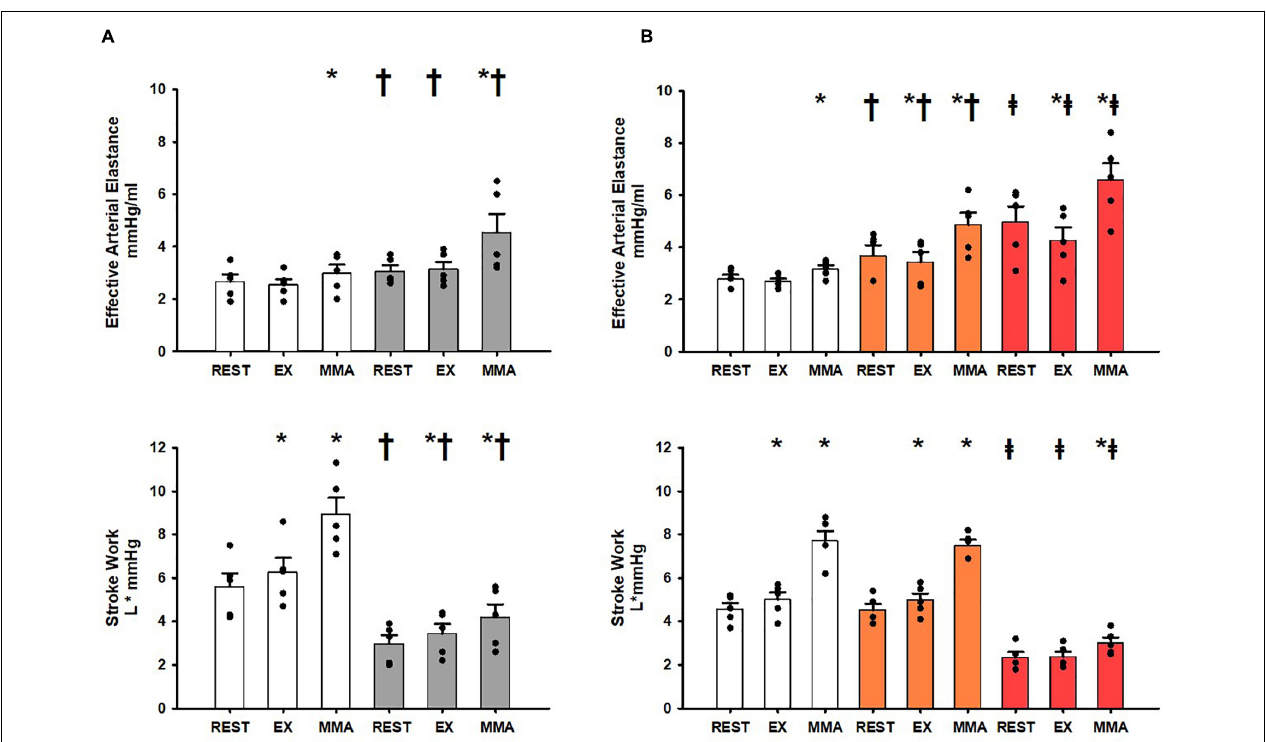
FIGURE 3 | (A) Average 1-min steady state values of Effective Arterial Elastance and Stroke Work in the Control group at rest, exercise (EX), and exercise with muscle metaboreflex activation (MMA) before (white) and after induction of heart failure (gray). Statistical significance vs. previous workload depicted * and vs. previous condition as † where P < 0.05. ( N = 5). (B) Average 1-min steady state values of Effective Arterial Elastance and Stroke Work in the SAD group at res, exercise (EX), and exercise with muscle metaboreflex activation (MMA) before (white) and after SAD (orange), and after heart failure induction post SAD (red). Statistical significance vs. previous workload depicted as * where P < 0.05. Comparisons of the condition of SAD vs. control depicted as † where P < 0.05. Comparisons of the condition of heart failure vs. SAD depicted as ‡ where P < 0.05. ( N = 5) Data for (A,B) are reported as means with standard error. Observed data points are overlain on corresponding bar